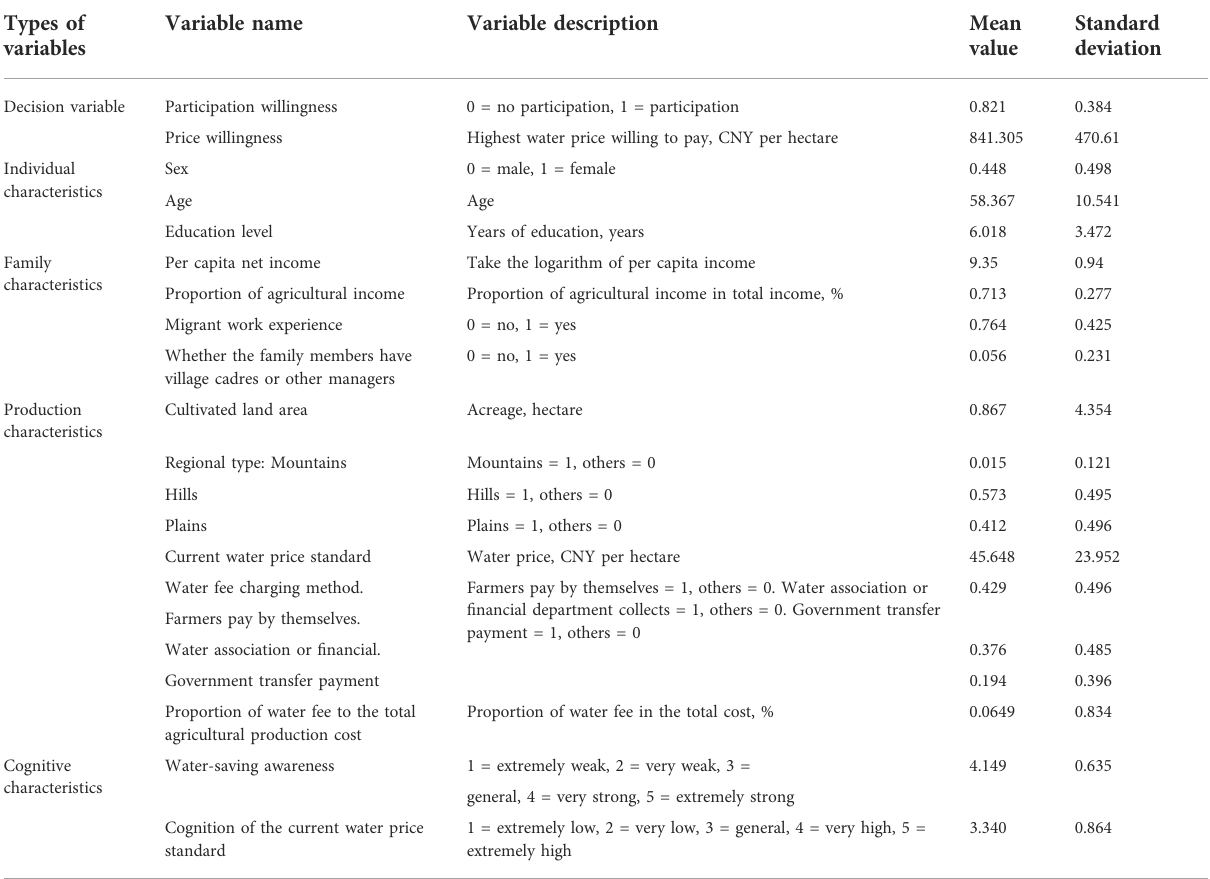
TABLE 3 De fi nitions of the variables and descriptive statistical